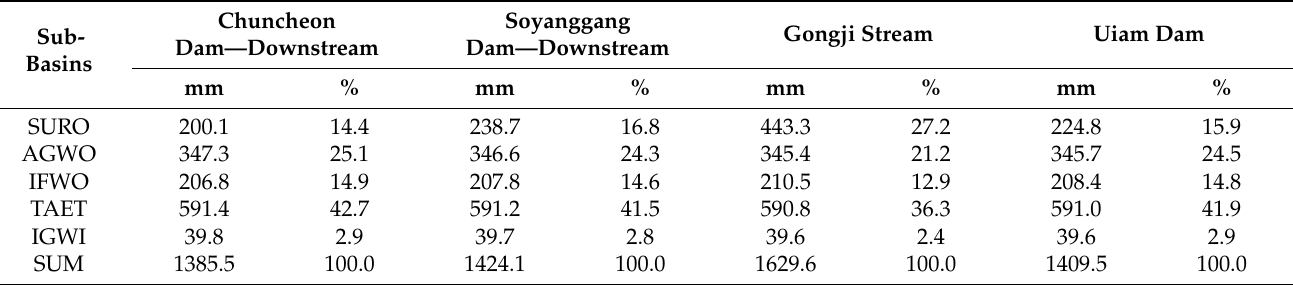
Table 4. Hydrologic components for each sub-watershed from Scenario 1.